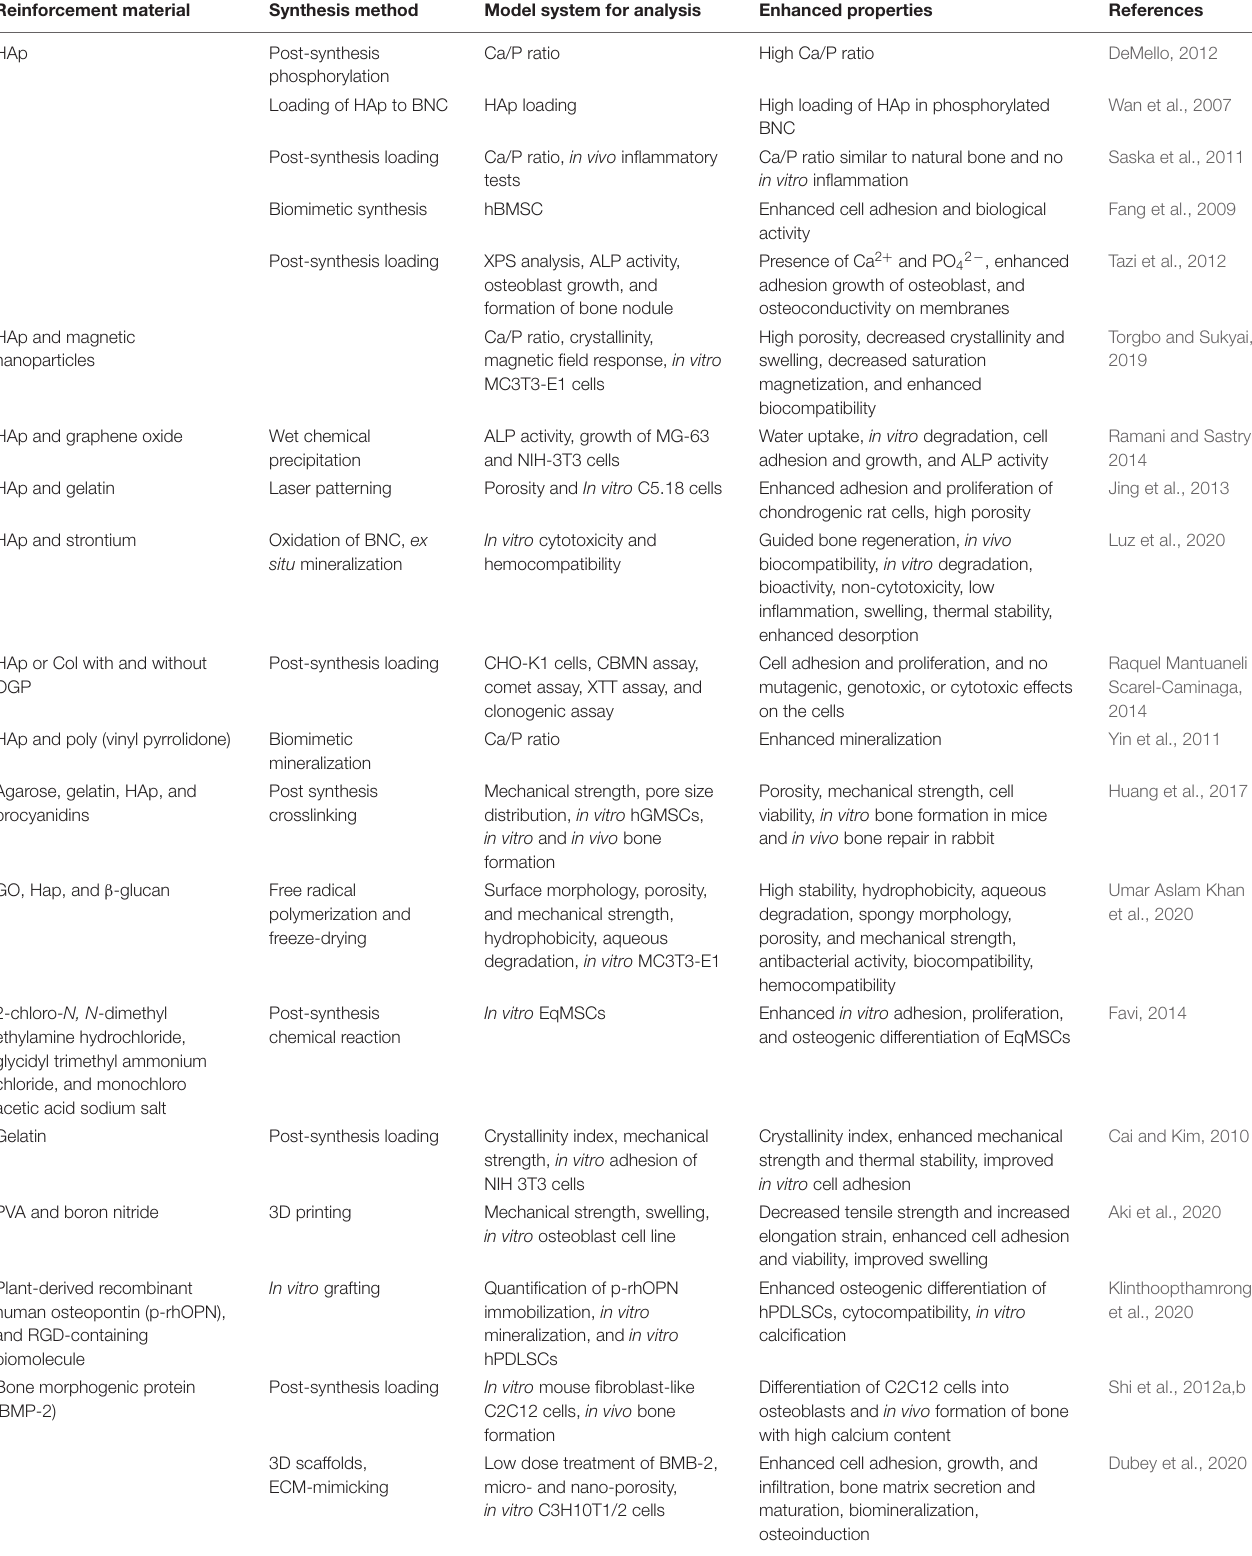
TABLE 1 | Applications of BNC-based biomaterials in bone